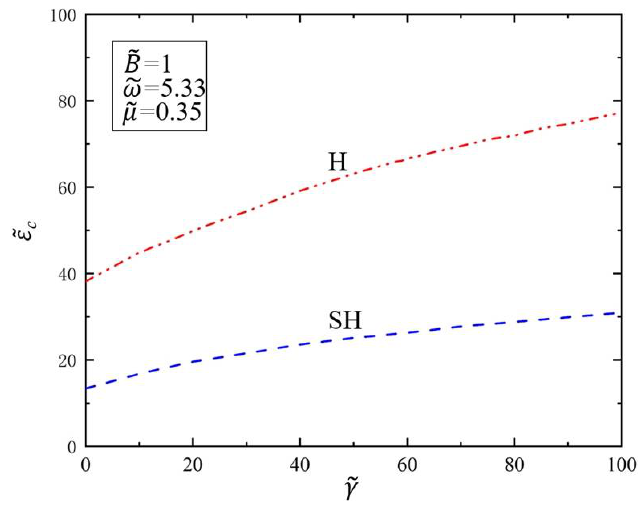
Figure 4. Variation of the critical wave number (cid:101) k c of the Faraday instability with driving frequency (cid:101) ω . The dimensionless parameters are (cid:101) γ = 1.7, (cid:101) µ = 0.35, and (cid:101) B = 1. The critical wave number (cid:101) k c increases with the increase in driving frequency (cid:101) ω .